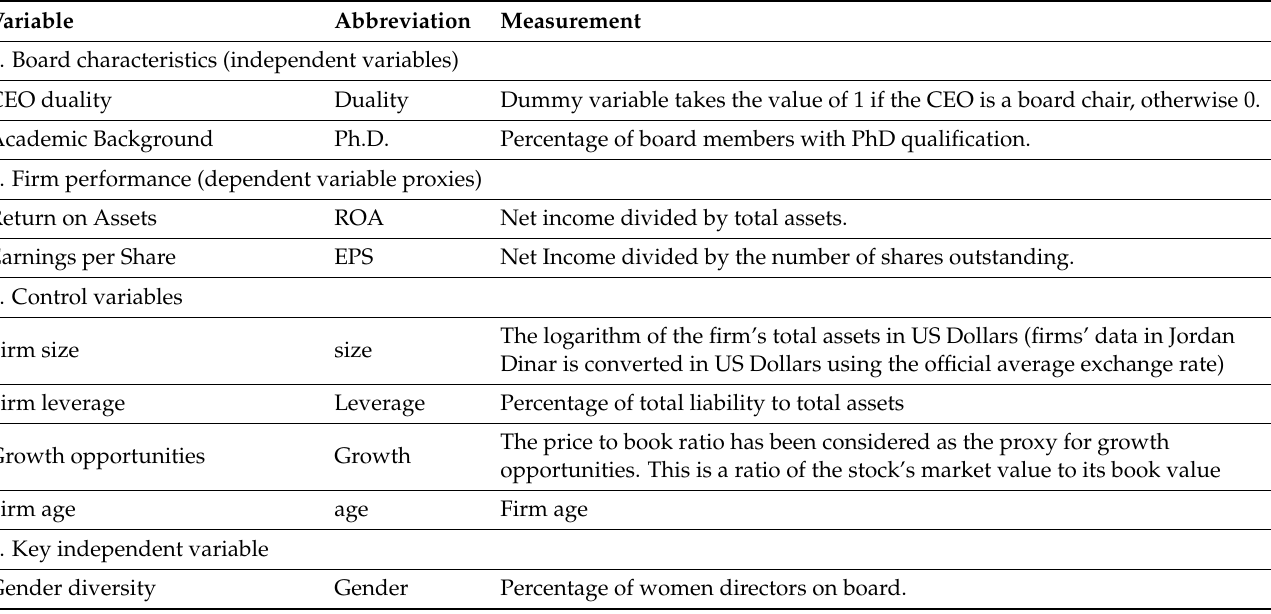
Table 1. The definition of each variable included in the